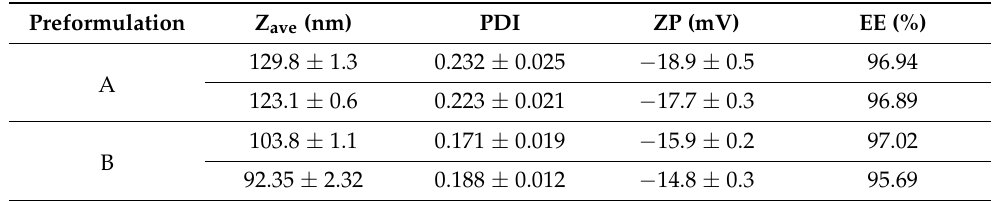
Table 2. Physicochemical characterization of the synthesis of nonoptimized DXI-NLCs. (A) NLCs with beeswax and castor oil; (B) NLCs with beeswax and Miglyol 812. Preformulation Z ave (nm) PDI ZP